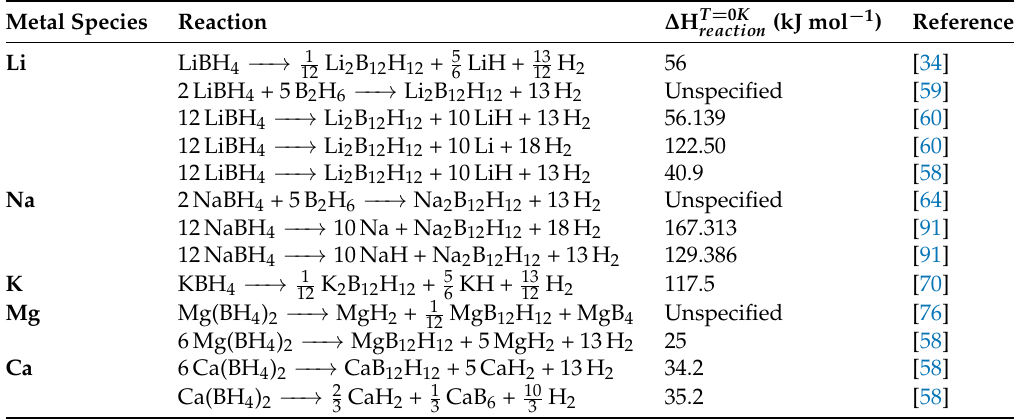
Table 6. Summary of the metal borohydride decomposition mechanisms that result in dodecaborate formation. Metal